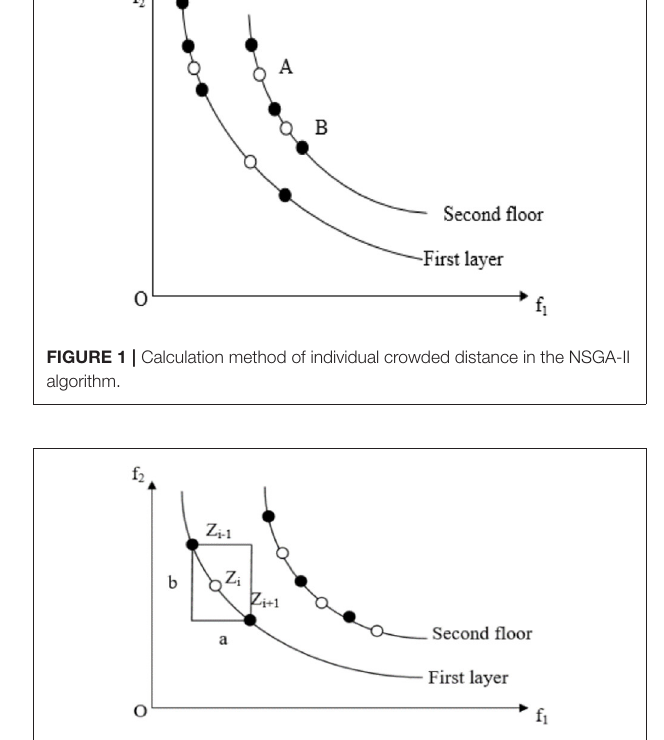
FIGURE 2 | Population individual distribution